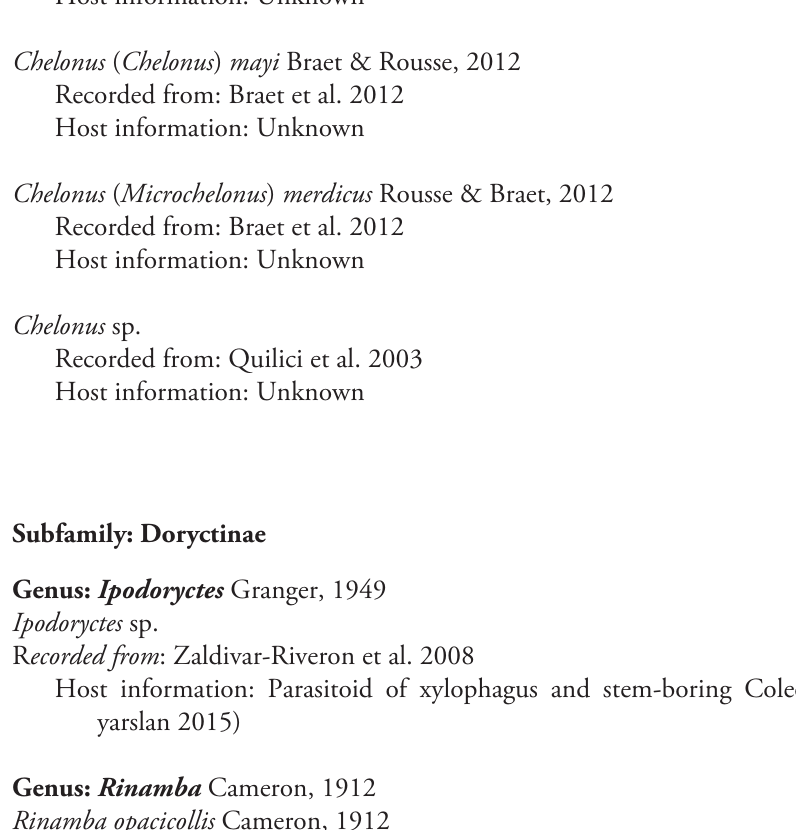
Rinamba opacicollis Cameron, 1912